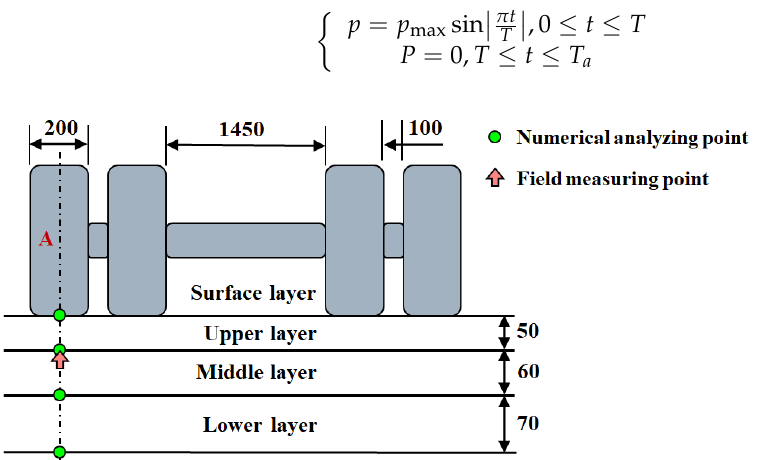
Figure 3. The vehicle loading model and the location of testing profile A (Unit: mm). Table 2. Vehicle speed and load